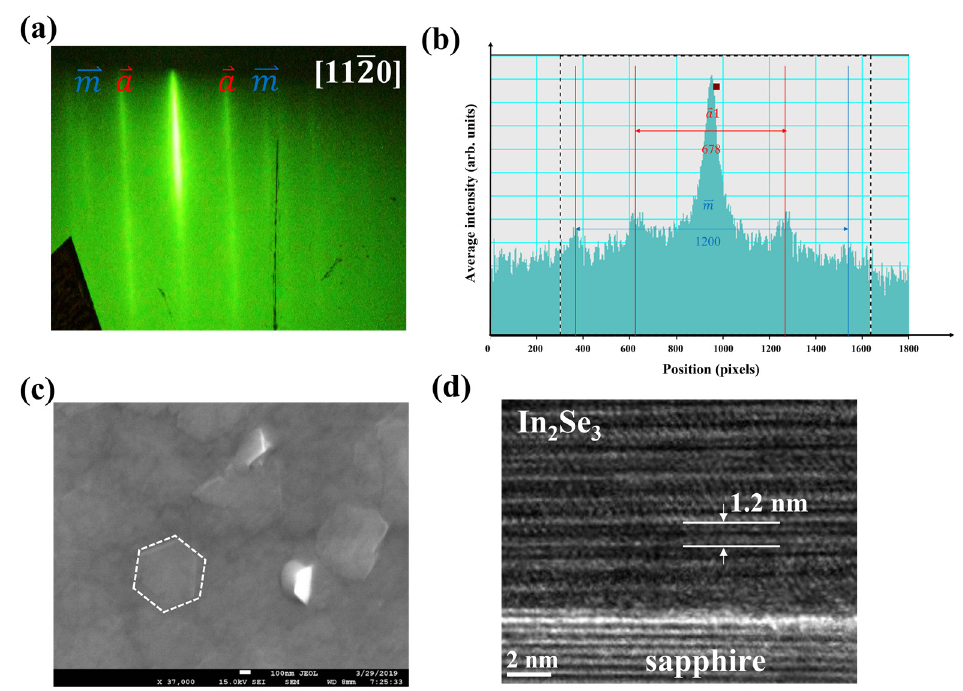
Figure 2. ( a ) The RHEED pattern of In 2 Se 3 films grown by T In at 740 °C, where 𝑎⃑ and 𝑚(cid:4652)(cid:4652)⃑ are indexed as diffraction from [10 1(cid:3364) 0] and [11 2(cid:3364) 0]. ( b ) intensity profile of ( a ). ( c ) A top-view SEM image of the α - In 2 Se 3 film. ( d ) A cross-sectional HR-TEM image of the α -In 2 Se 3